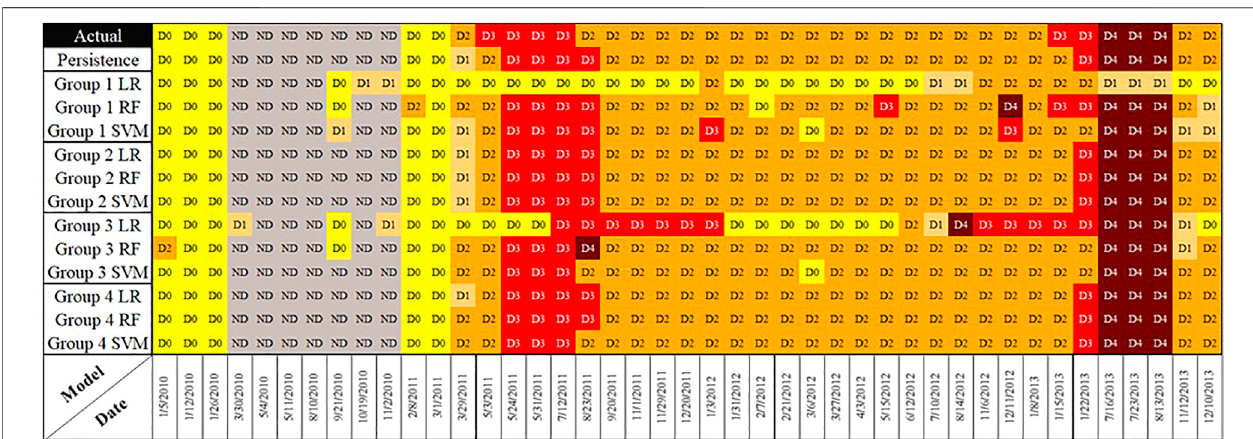
FIGURE 8 | Time series of test data of grid cell located in (35.0629, − 105.3130) New Mexico.